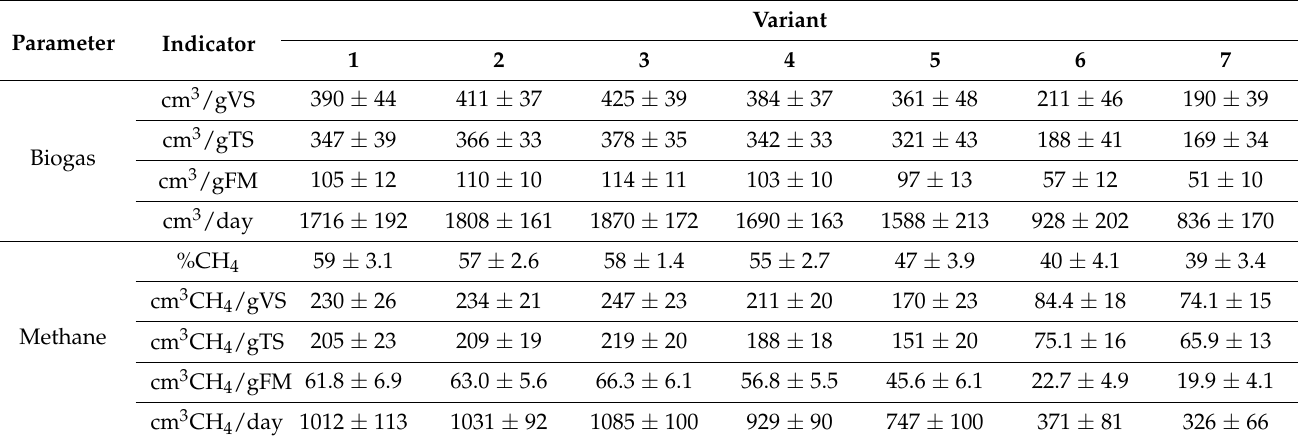
Table 4. Specific biogas and methane production indicators by